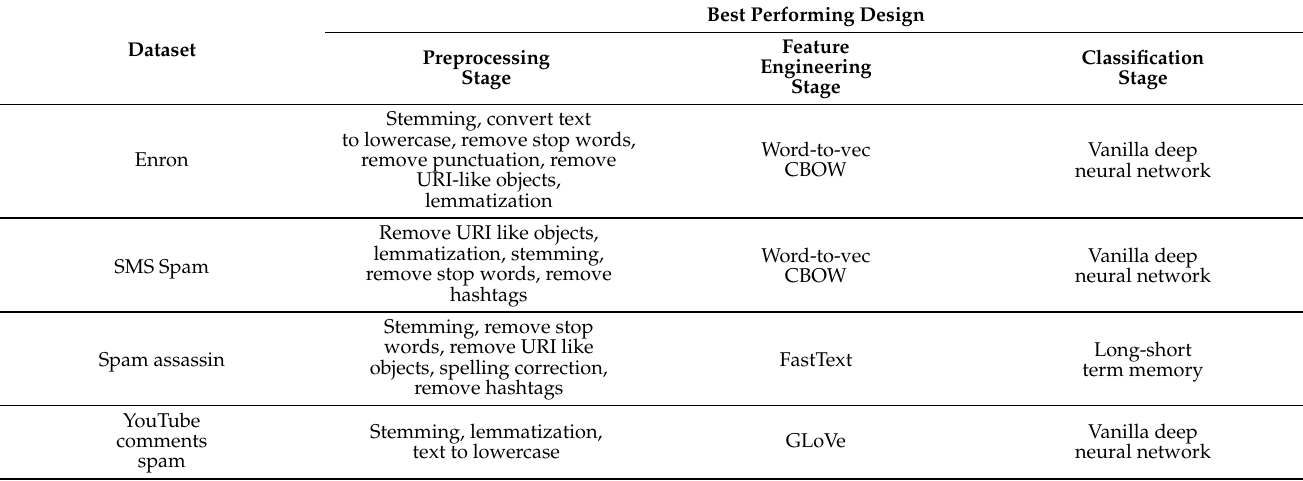
Table 17. Best-performing designs produced by the SPHH for the spam detection